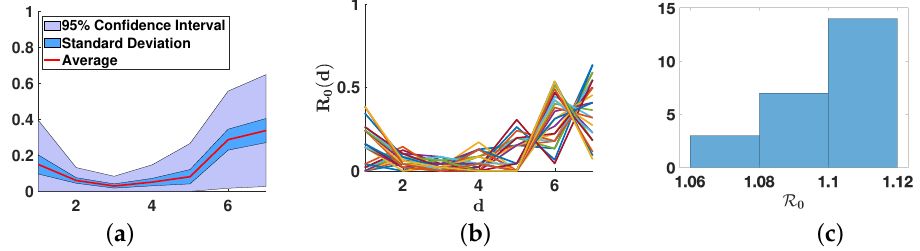
− λ | 2 2 ( d ) (red curve), 0 R 0 ( d ) . d = 1